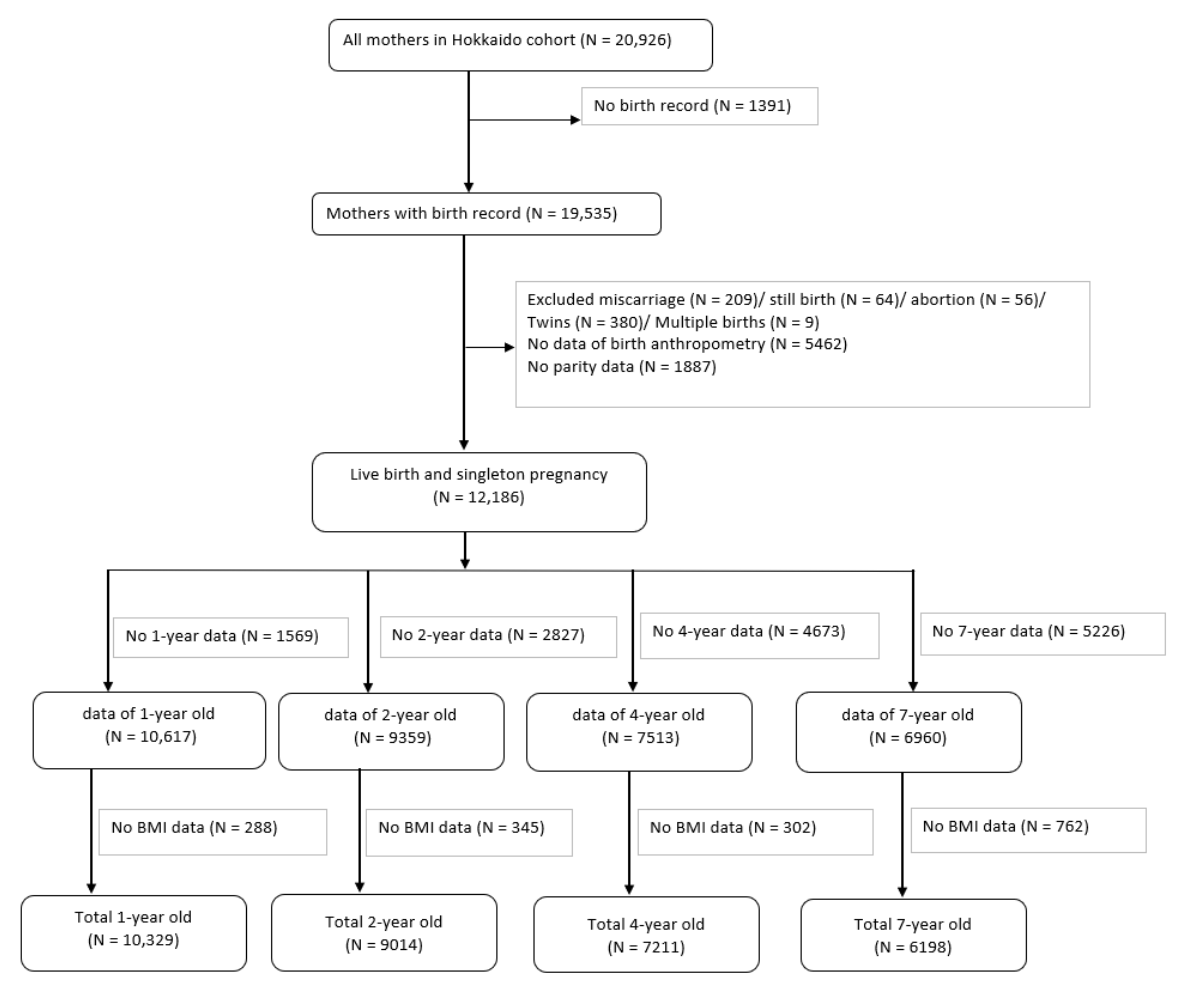
Figure 1. Flowchart of the study.